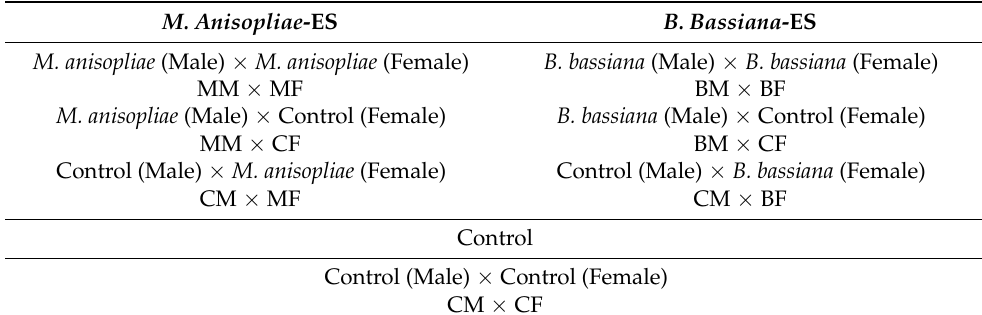
Table 2. Treatment combinations of moths that emerged from pupae exposed to emulsifiable suspen- sions of Metarhizium anisopliae and Beauveria bassiana